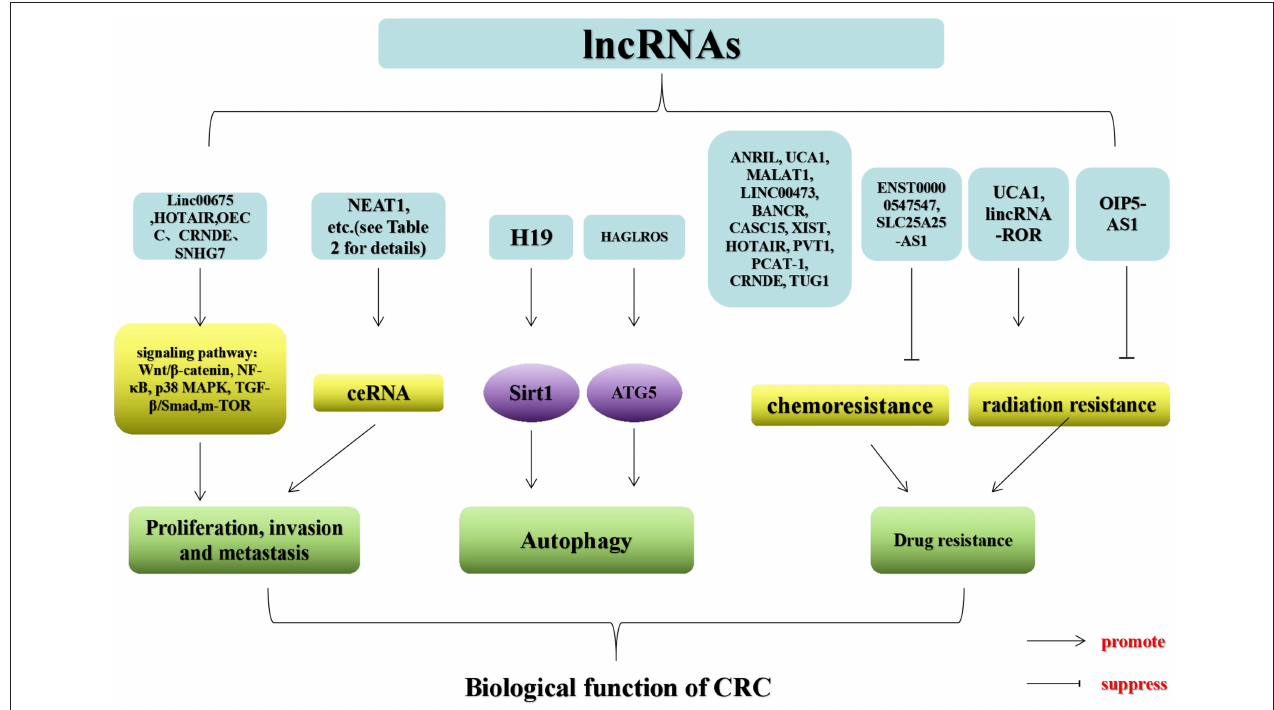
FIGURE 1 | Regulatory mechanisms of lncRNAs that may be associated with CRC. SWI/SNF (chromatin remodeling complex); BAF170 (SWI/SNF-related, matrix-associated, actin-dependent regulator of 67 chromatin subfamily c member 2); lncRNA TCF7 (lncRNA T-cell factor 7); TFs (transcription factors); RISC (RNA-induced silencing complexes); SF (splicing factor); hnRNP1 (heterogeneous nuclear ribonucleoprotein